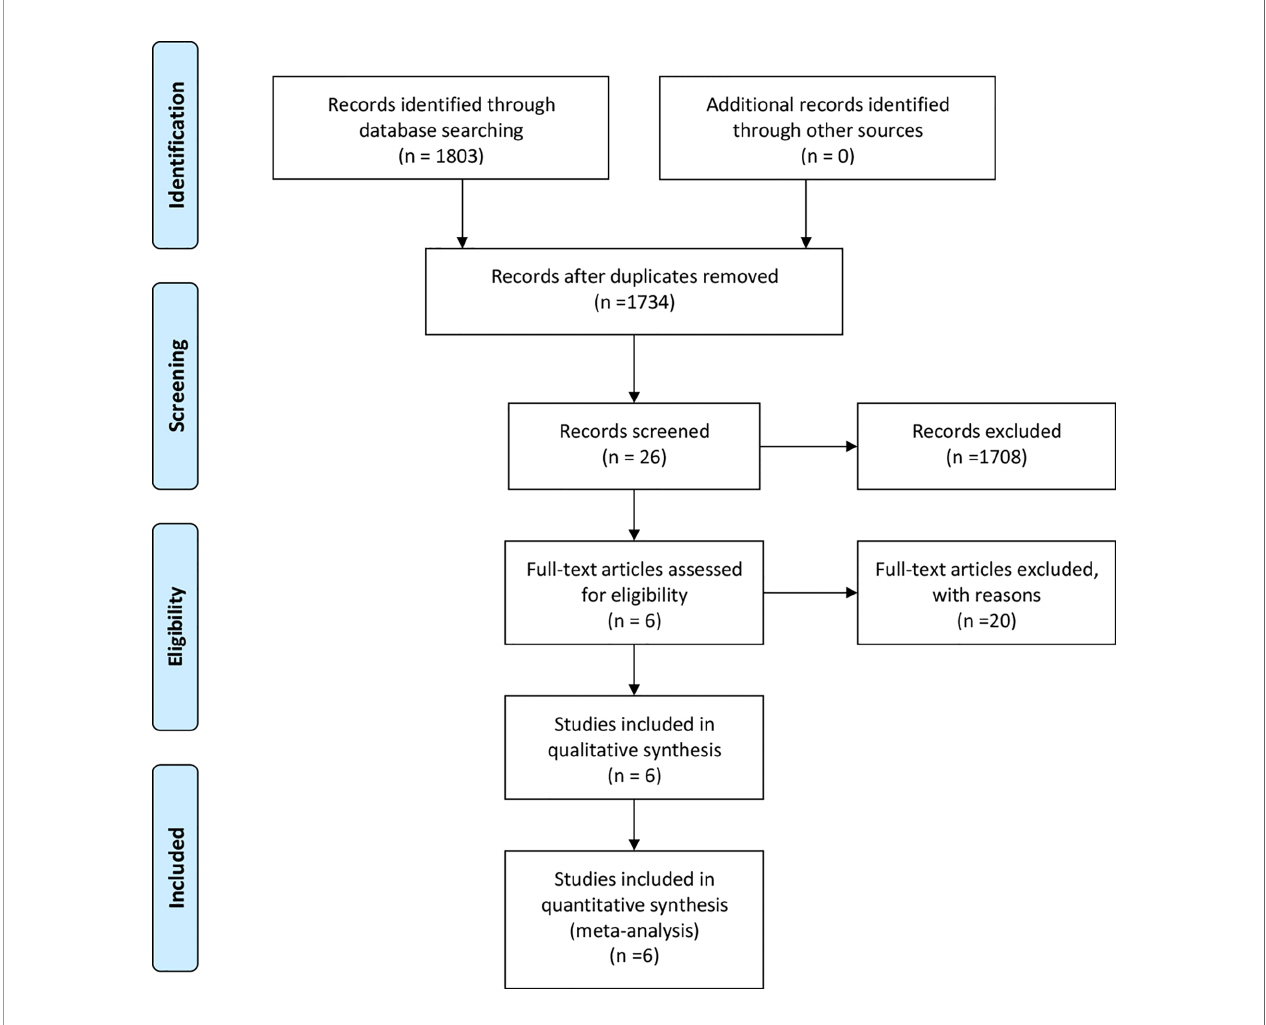
FIGURE 1 | Flow chart of study identi fi cation and selection.